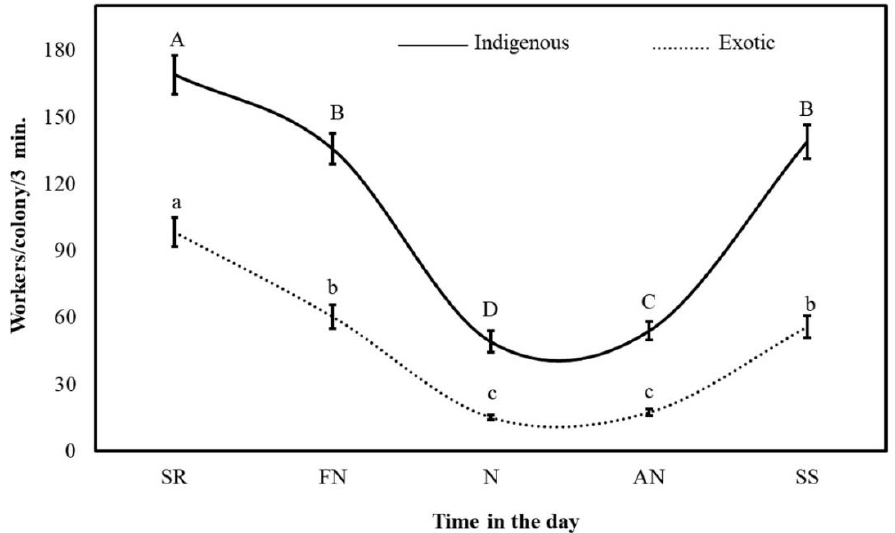
Figure 3. The hourly foraging rates (mean ± SE) of indigenous ( Apis mellifera jemenitica ) and exotic ( A.m. carnica ) honeybee colonies during the Acacia gerrardii flow (May-August) in Central Arabia for the 2017 and 2018 seasons. (SR: sunrise; FN: forenoon; N: noon; AN: afternoon; SS: sunset). The same letter in the same chart line are not significantly ( p ˃ 0.05) different.